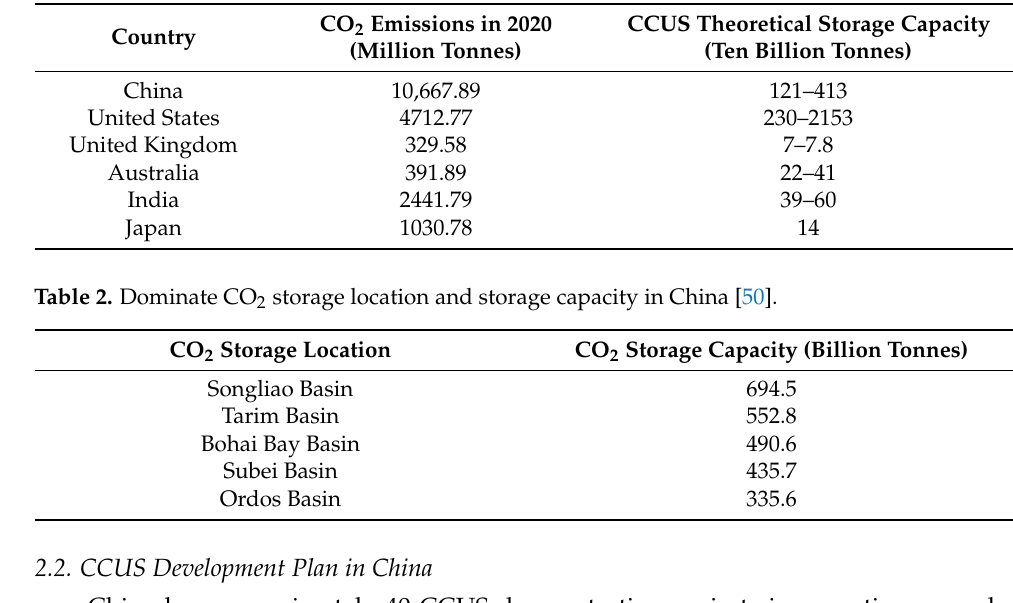
Table 1. CO 2 emissions and CCUS theoretical storage capacity in some countries [50,55,56].